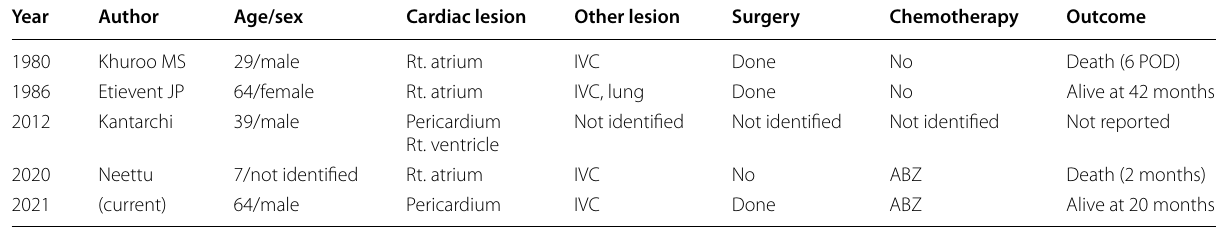
Rt, right; IVC, inferior vena cava; ABZ,